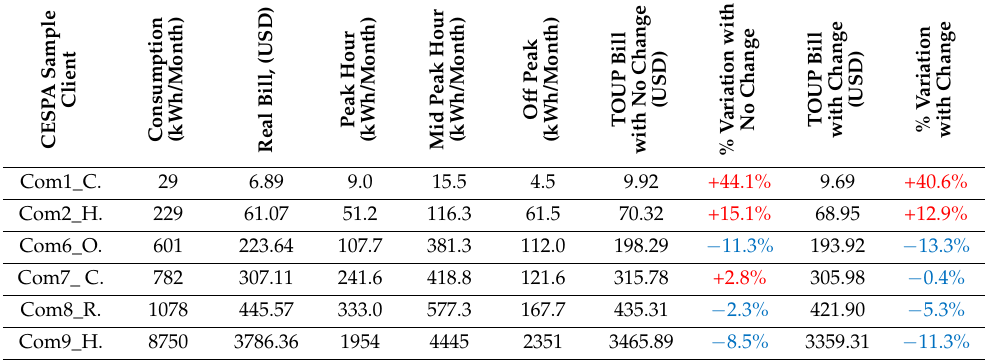
Table 8. Variation in invoices for commercial customers with TOUP in trends of February